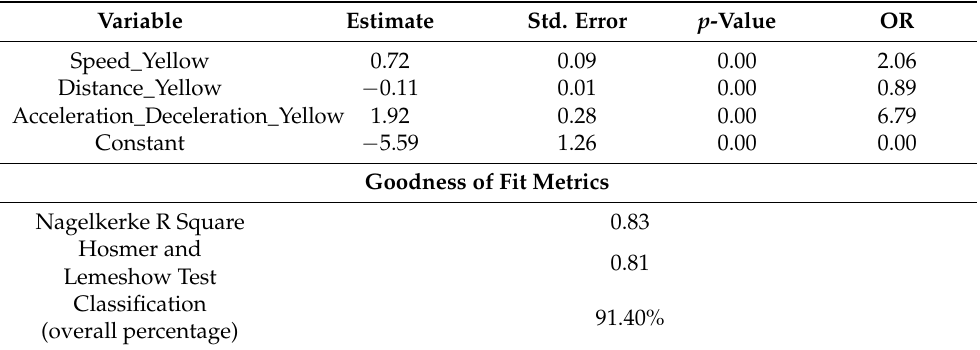
Table 5. Parameter estimates of the initial binary choice